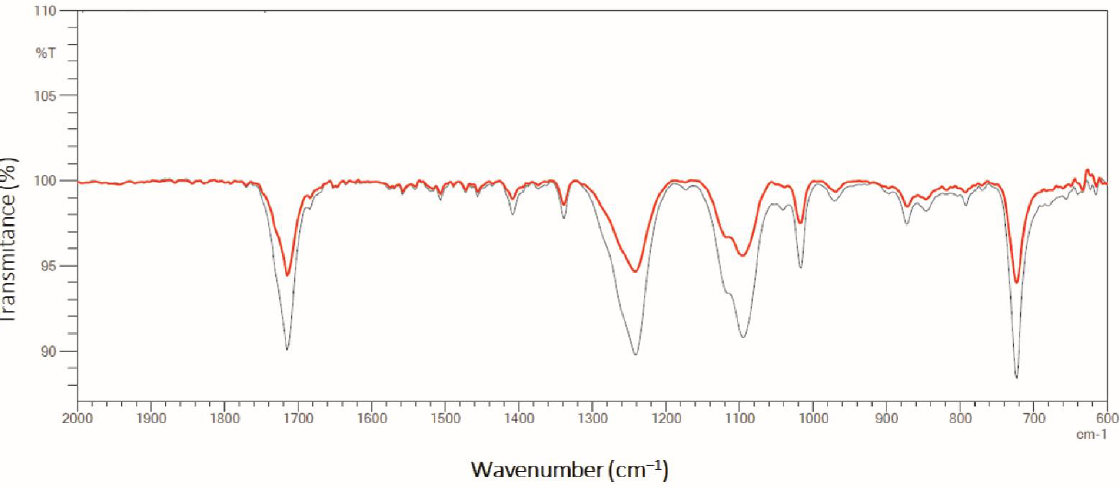
Figure 12. ATR-FTIR spectrum before (black line) and after (red line) the biodepolymerization process during Y. lipolytica cultivation in bioreactors (450 rpm, 1 vvm and 28 °C) containing YT + PC-PET (500 mg/L) for 96 h.